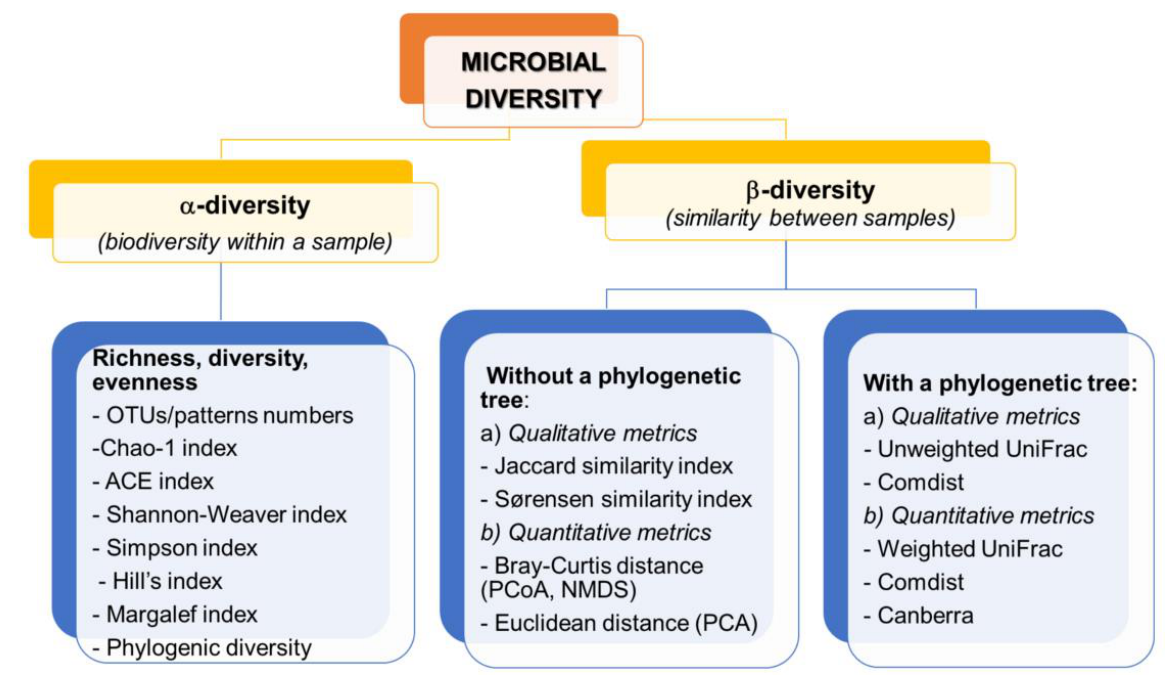
Figure 3. Examples of metrics characteristic for α- and β-diversity.